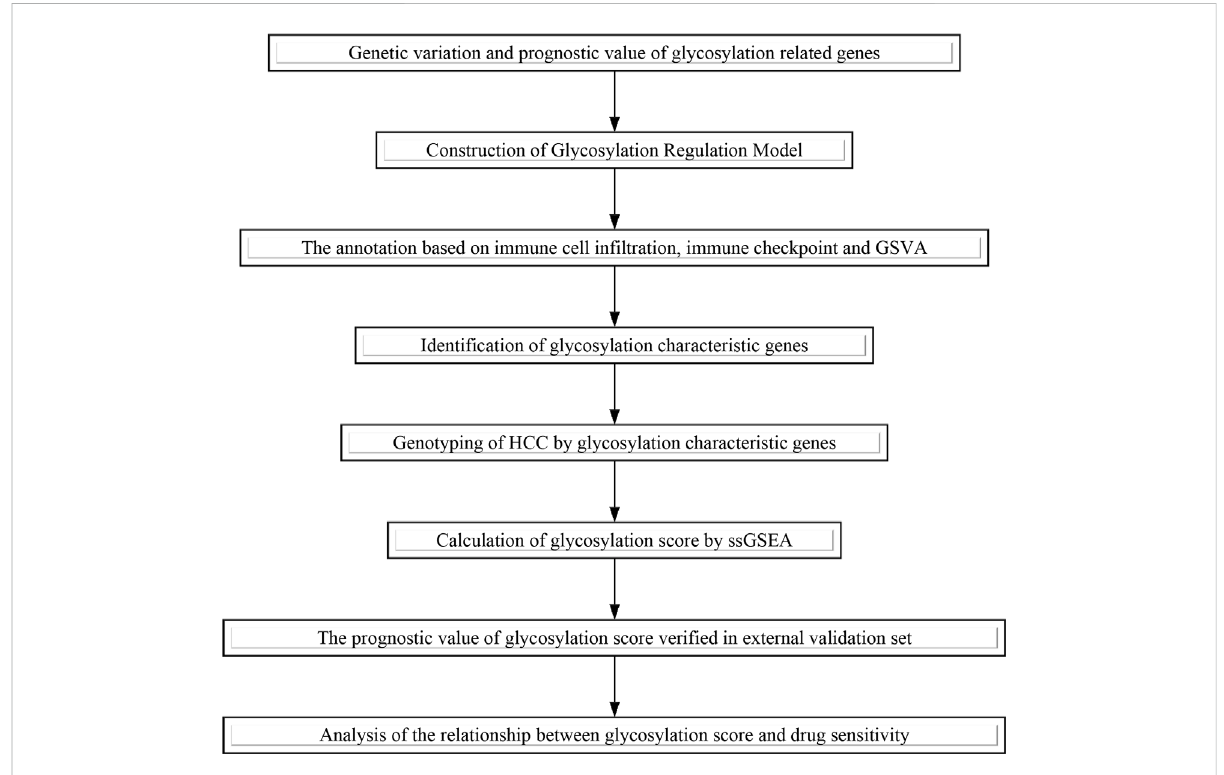
FIGURE 1 Flow-process